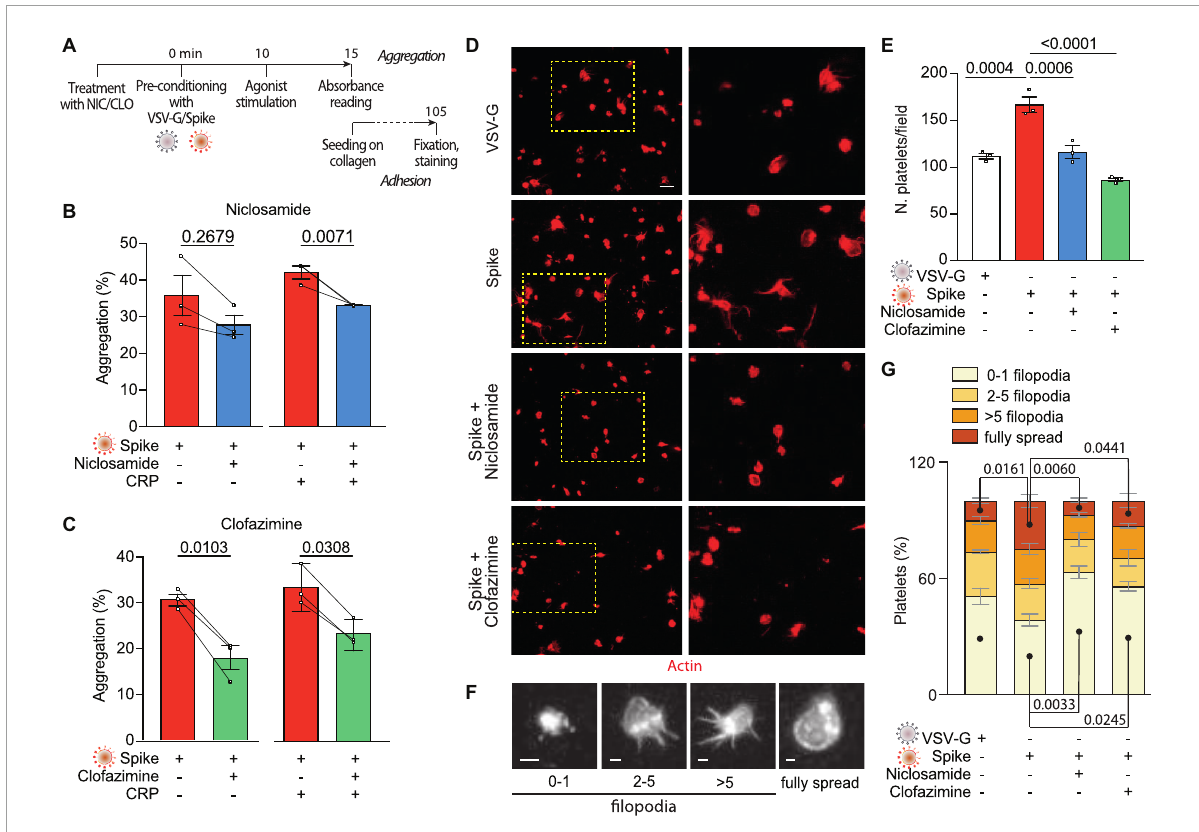
FIGURE3 Niclosamide and Clofazimine inhibits Spike-induced activation of platelets. (A) Experimental scheme to assess the effect of drugs on platelet activation. Washed platelets were incubated with Niclosamide, Clofazimine (C) or vehicle for 10 min, then incubated with 1:10 diluted Spike or VSV-G pseudoparticles for further 10 min. Aggregation and adhesion were evaluated as described in Figure 1 . (B,C) Percentage of platelet aggregation upon treatment with Spike in the presence of either Niclosamide (B) or Clofazimine (C) , and respective DMSO controls, with or without CRP. Results are from n = 3 independent experiments. Data are mean ± SEM. Statistical significance is indicated (paired Student’s t -test). (D) Representative images of platelets adhering on collagen (magnification in the right panels). Platelets are stained in red for F-actin. Scale bar, 5 µ m. (E) Number of adherent platelets per field. Results are from n = 3 independent experiments performed in duplicate. Each dot represents the mean of six quantified images. Data are mean ± SEM. Statistical significance is indicated (unpaired Student’s t -test). (F) Representative images of platelet morphological changes. Adherent platelets were classified into four morphological categories representing different stages of platelet adhesion and activation: platelets with 0–1, 3–5, more than five protrusions or fully spread platelets, as indicated by the representative images under the graph. Scale: 1 µ m. (G) Platelet morphological changes upon Spike and drug treatment. Results are from n = 3 independent experiments performed in duplicate. Data are mean ± SEM. Statistical significance is shown for the indicated morphological categories (one-way ANOVA with Dunnett’s post-hoc correction for multiple